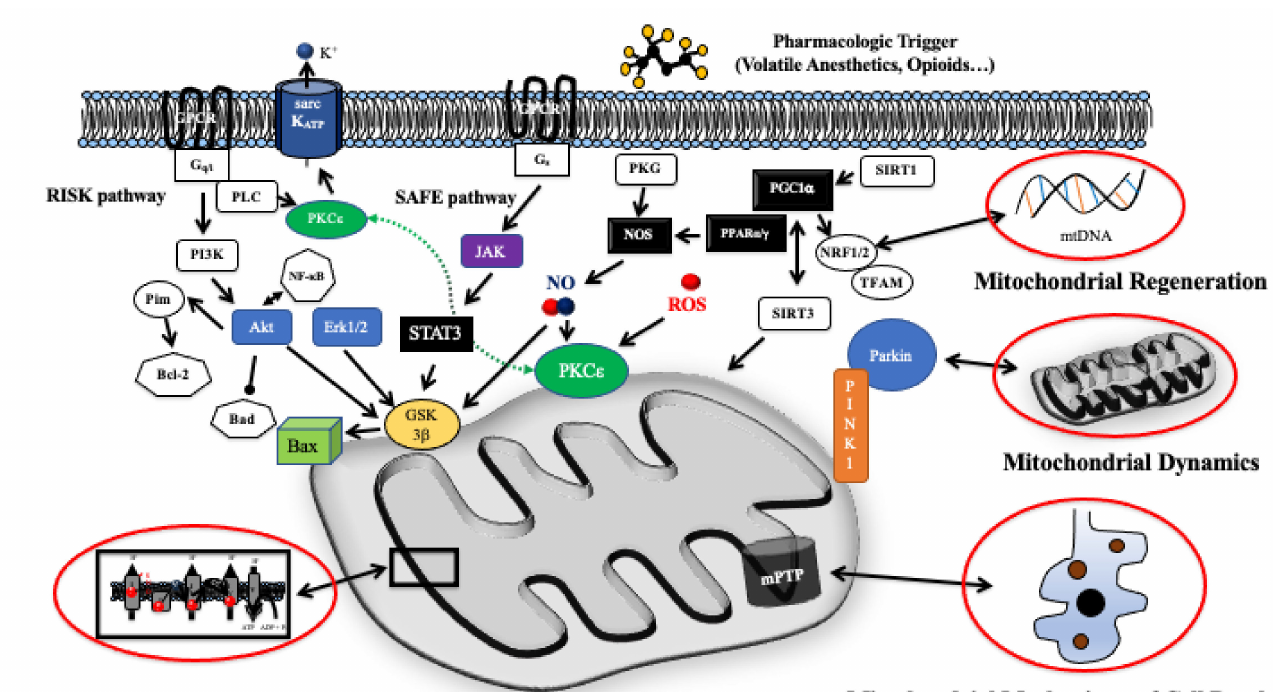
Figure 1. Schematic depiction of (pre-) mitochondrial signaling in myocardial I/R injury and pharmacologic cardioprotection. Mitochondria host diverse signaling modules at the crossroads of cell survival and cell death. Cytosolic signaling pathways transduce the protective signaling into resulting in modulation of mitochondrial respiratory chain activity and finally the prevention of mitochondria related cell death. Moreover, mitochondrial dynamics and mitochondrial regeneration via transcriptional changes of the mitochondrial proteome modulation contribute to an enhanced intrinsic resistance against I/R injury. Abbreviations: Akt = protein kinase B; Bax = Bcl-2-associated X protein; Bad = Bcl-2-Antagonist of Cell Death; Bcl-2 = B-cell lymphoma-2 protein; Erk1/2 = extracellular regulated kinase 1 and 2; GSK3 β = glycogen synthase kinase 3 β ; Jak = janus-activated kinase; mPTP = mitochondrial permeability transition pore; NO = nitric oxide; NOS = nitric oxide synthase; PI3K = phosphoinositid-3-kinase; PGC1 α = peroxisome proliferator-activated receptor gamma coactivator 1- α ; Pim = proto-oncogene serine/threonine-protein kinase; PINK1 = PTEN-induced kinase 1; PKC ε = protein kinase C ε ; PKG = proteinkinase G; PPAR α / β = peroxisome proliferator activated receptor α / β ; Nf κ B = nuclear factor κ B; NRF1/2 = Nuclear respiratory factor 1/2; RISK = reperfusion injury salvage kinase; sarcK ATP = sarcolemmal ATP- dependent potassium channel; SAFE = survival activating factor enhancement; SIRT1/2 = Sirtuin-1/2; STAT3 = signal transducer and activator of transcription 3; TFAM = mitochondrial transcription factor